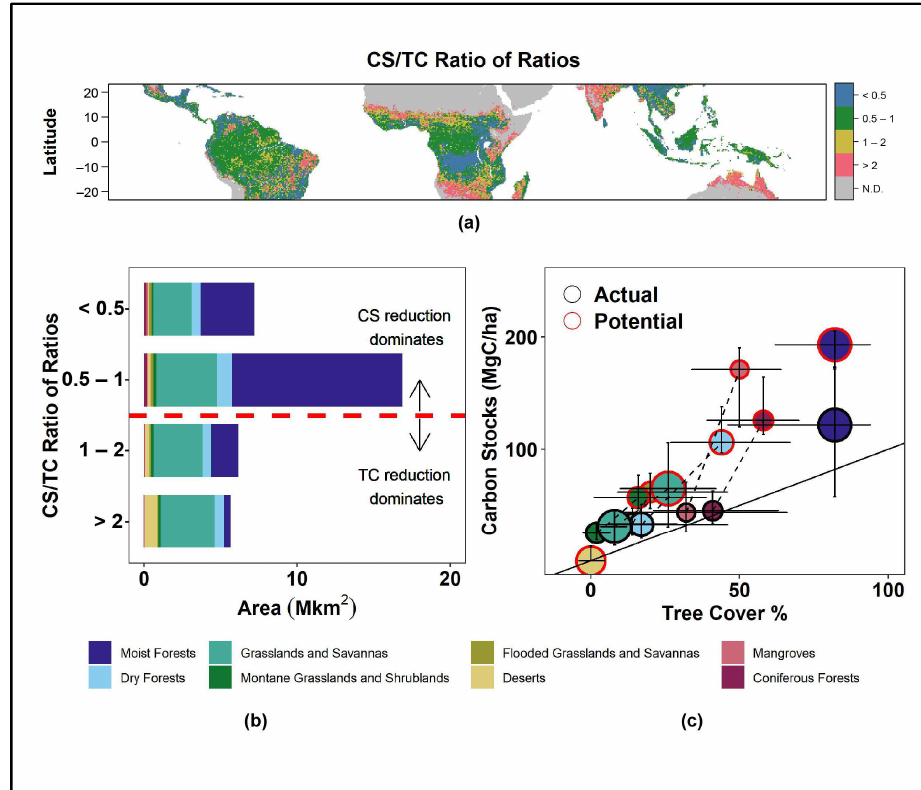
Figure 2. Land use impacts on CS and TC across tropical biomes. ( a ) The CS/TC Rratio of Ratios across the tropics. ( b ) Histogram of areal distribution of the CS/TC Ratio of Ratios classified by biome-type. Values in A and B < 1 indicate a stronger effect of land use on CS than on TC; values > 1 indicate the opposite. ( c ) Median of potential (red border circles) and actual (black border circles) TC and CS, classified by biome-type. Whiskers indicate the inner quartiles of values in each biome in the potential TC map, the median actual TC map, the median potential CS map, and the median actual CS map. The circle size is proportional to the areal extent of the biome.